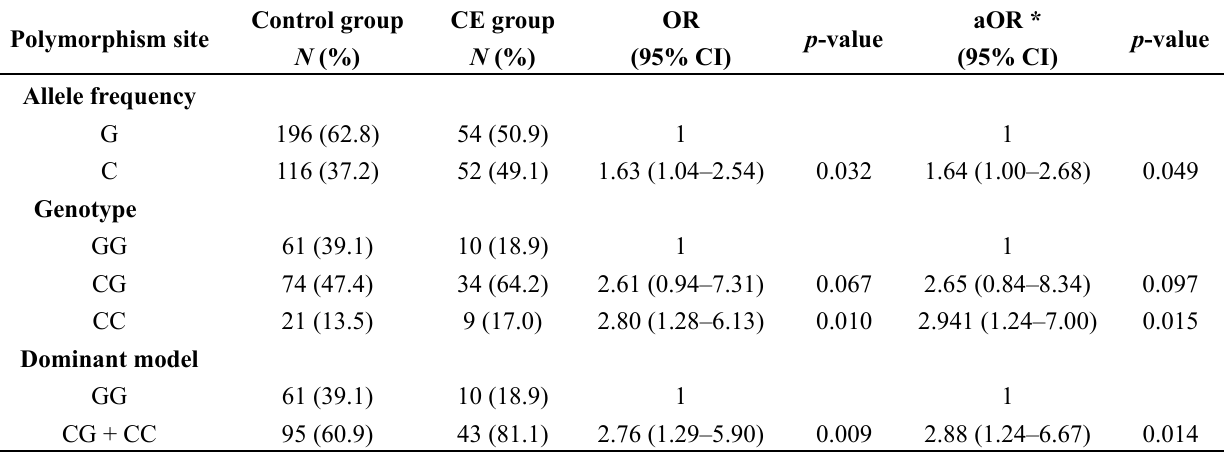
Table 4. hOGG1 Ser326Cys genotype and ectasia status in subgroup